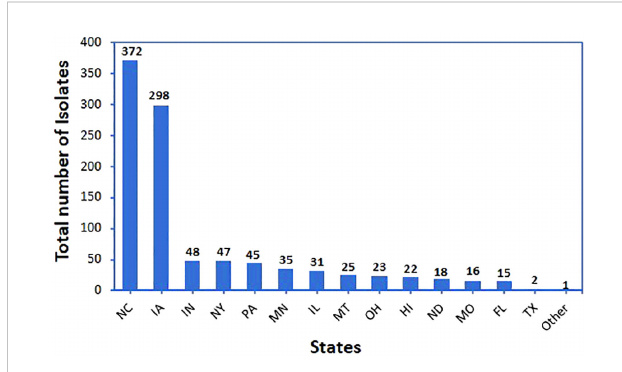
FIGURE 1 Total number of bacterial isolates and their origin state. All these isolates were evaluated in the initial screen against Phakopsora pachyrhizi using a detached-leaf